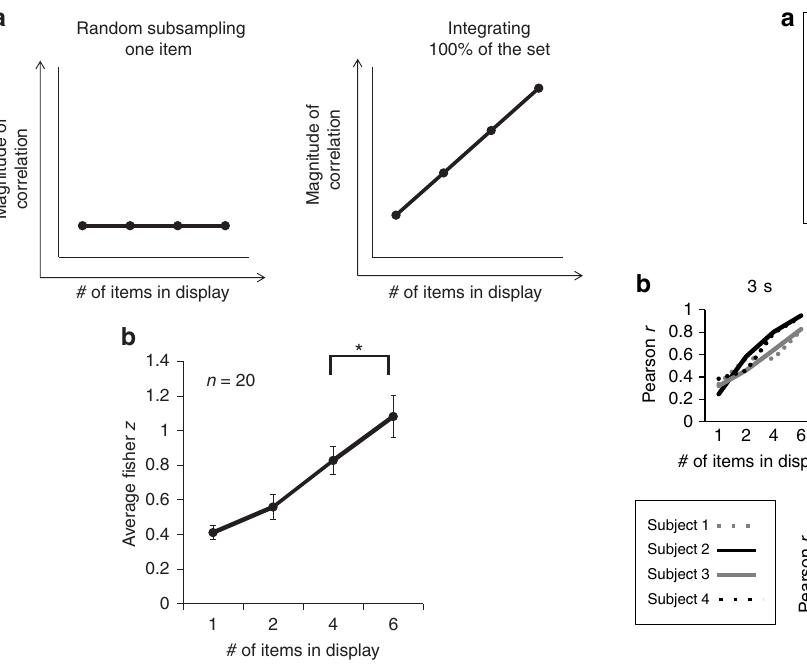
Figure 3 | Hypothetical and empirical results for Experiment 2. ( a ) Hypothetical outcomes for the subset conditions, comparing participants’ performance during random subsampling of one object or during ensemble coding (an extreme version of ensemble coding in which 100% of the objects in the set are integrated). Left: If the participant randomly samples lifelikeness information from just one item in the set, the magnitude of the correlation should remain relatively constant, even when more information becomes available because the participant does not use the new information. Right: In contrast, if the participant integrates lifelikeness information from every item as it becomes available to them, the correlation between participants’ lifelikeness ratings and the predicted lifelikeness ratings of the crowd should increase as more information (more items) becomes available. ( b ) Experiment 2 Results. The Fisher z scores increase as the number of items displayed increases. This pattern indicates that participants integrated the available information and did not use a random subsampling technique to accomplish the task. Error bars represent s.e.m. second experiment at five different exposure durations with experienced psychophysical observers (see Methods). Subsets of stimuli (as in the second experiment) were presented for durations of 50 ms, 250 ms, 500 ms, 1 s or 3 s. In each trial, participants foveated on a fixation cross, and viewed up to six stimuli, which were displayed isoeccentrically around the fixation cross (see Fig. 4a, also see Methods). The different exposure durations and subset conditions (1, 2, 4, 6 stimuli per set) were randomly interleaved (52 trials each), totalling 1040 trials per participant.